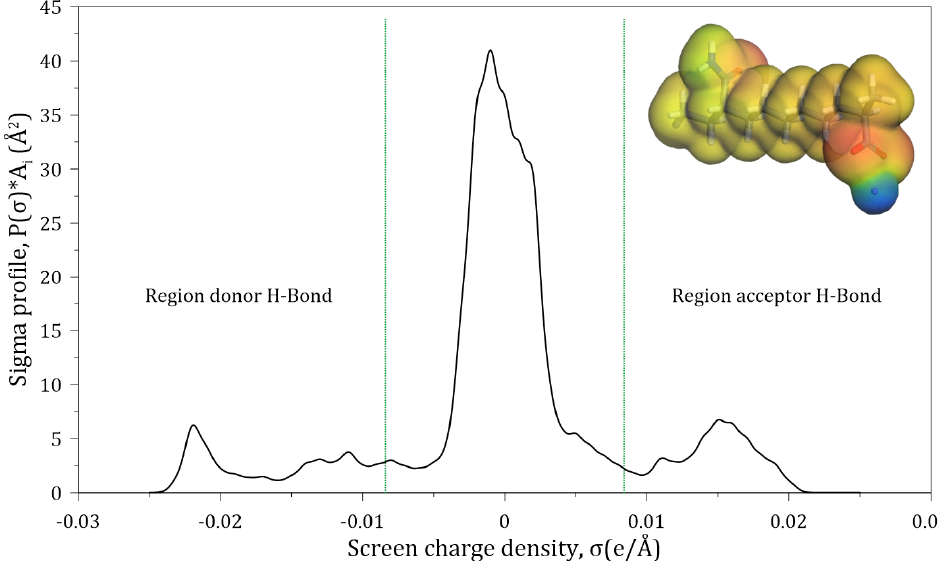
Figure 3. Sigma profile of a HPAM segment surface.